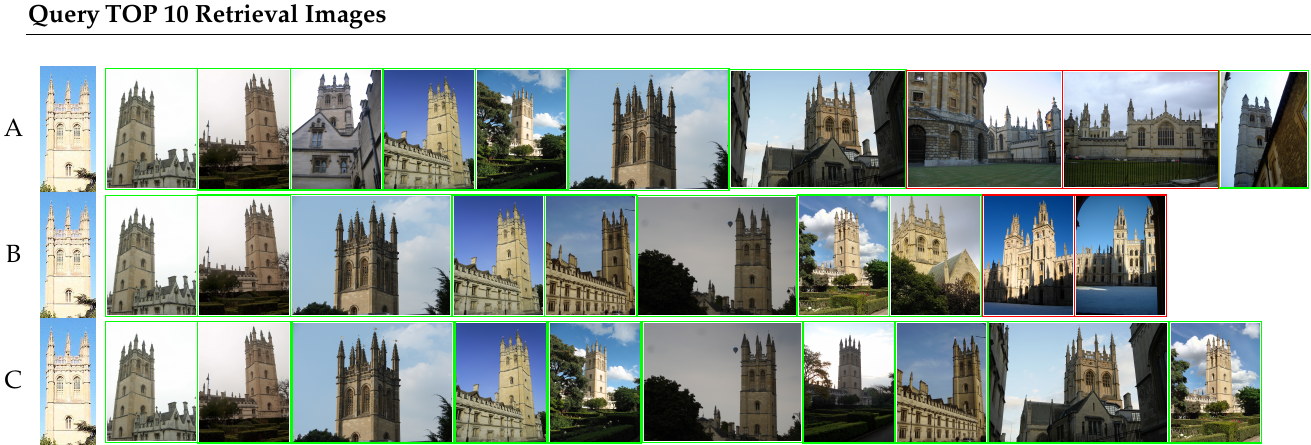
Table 7. Image retrieval comparison of G-CCA with MAC, AVE, and SD